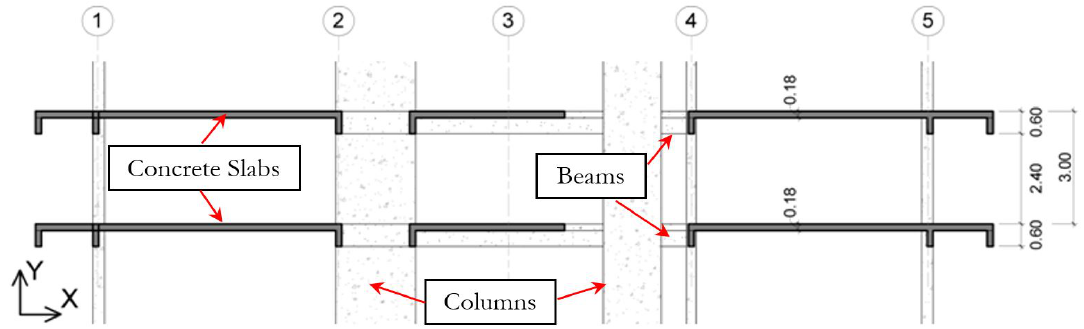
Figure 6. Detail of the concrete slabs thickness and height